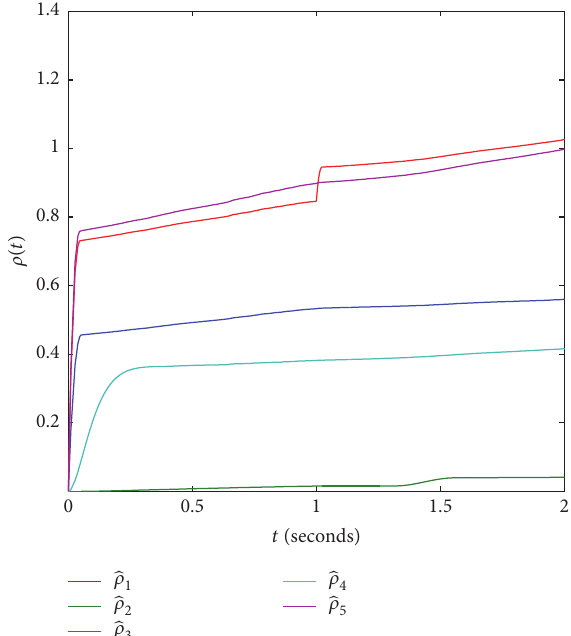
Figure 8: Time response of the estimated value of 𝜌 𝑖 (𝑡)